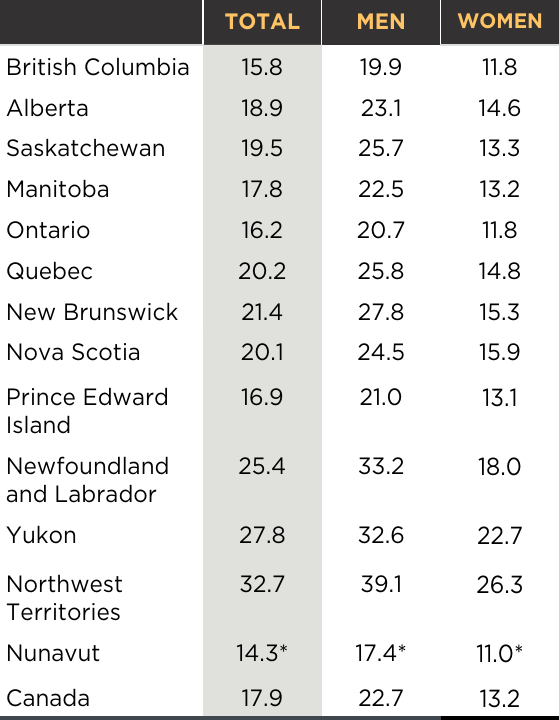
Table 3: RATES OF HEAVY DRINKING IN